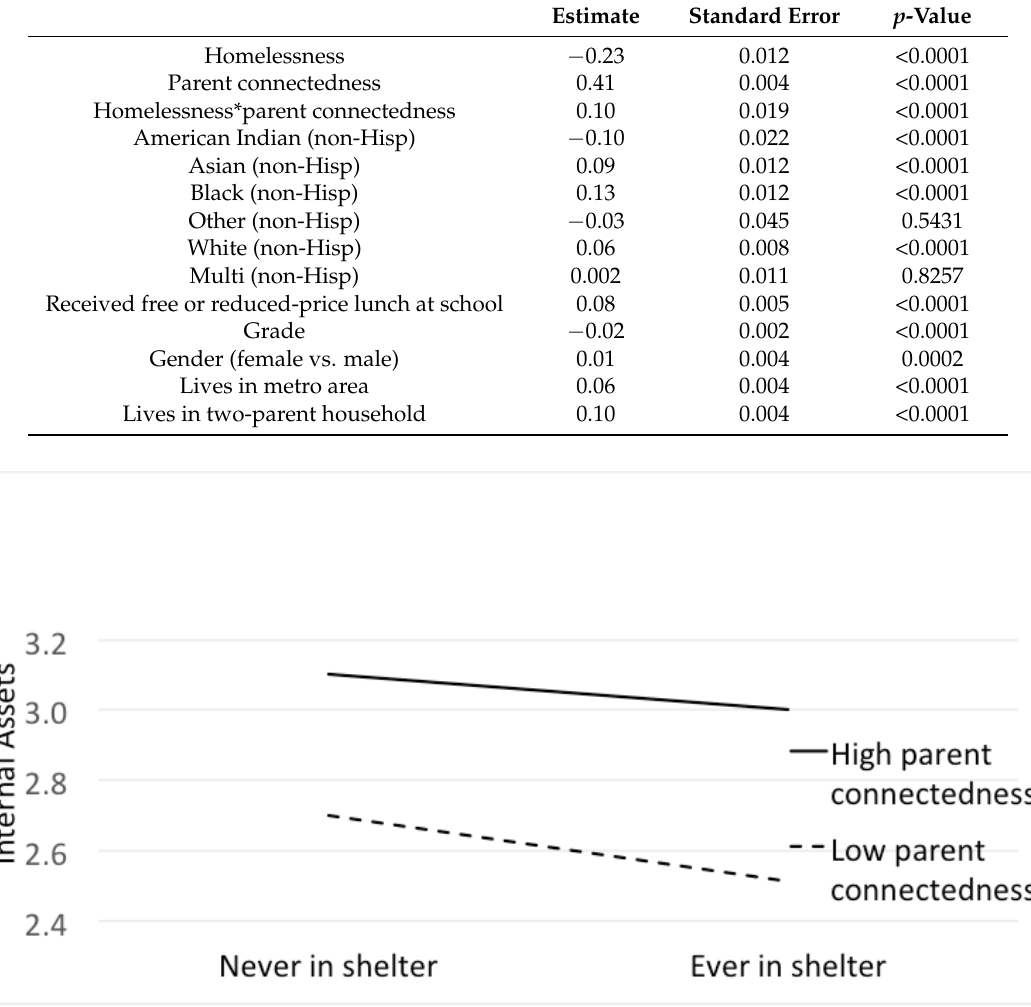
Figure 1. Internal assets, by parent connectedness, for homeless vs. housed youth.